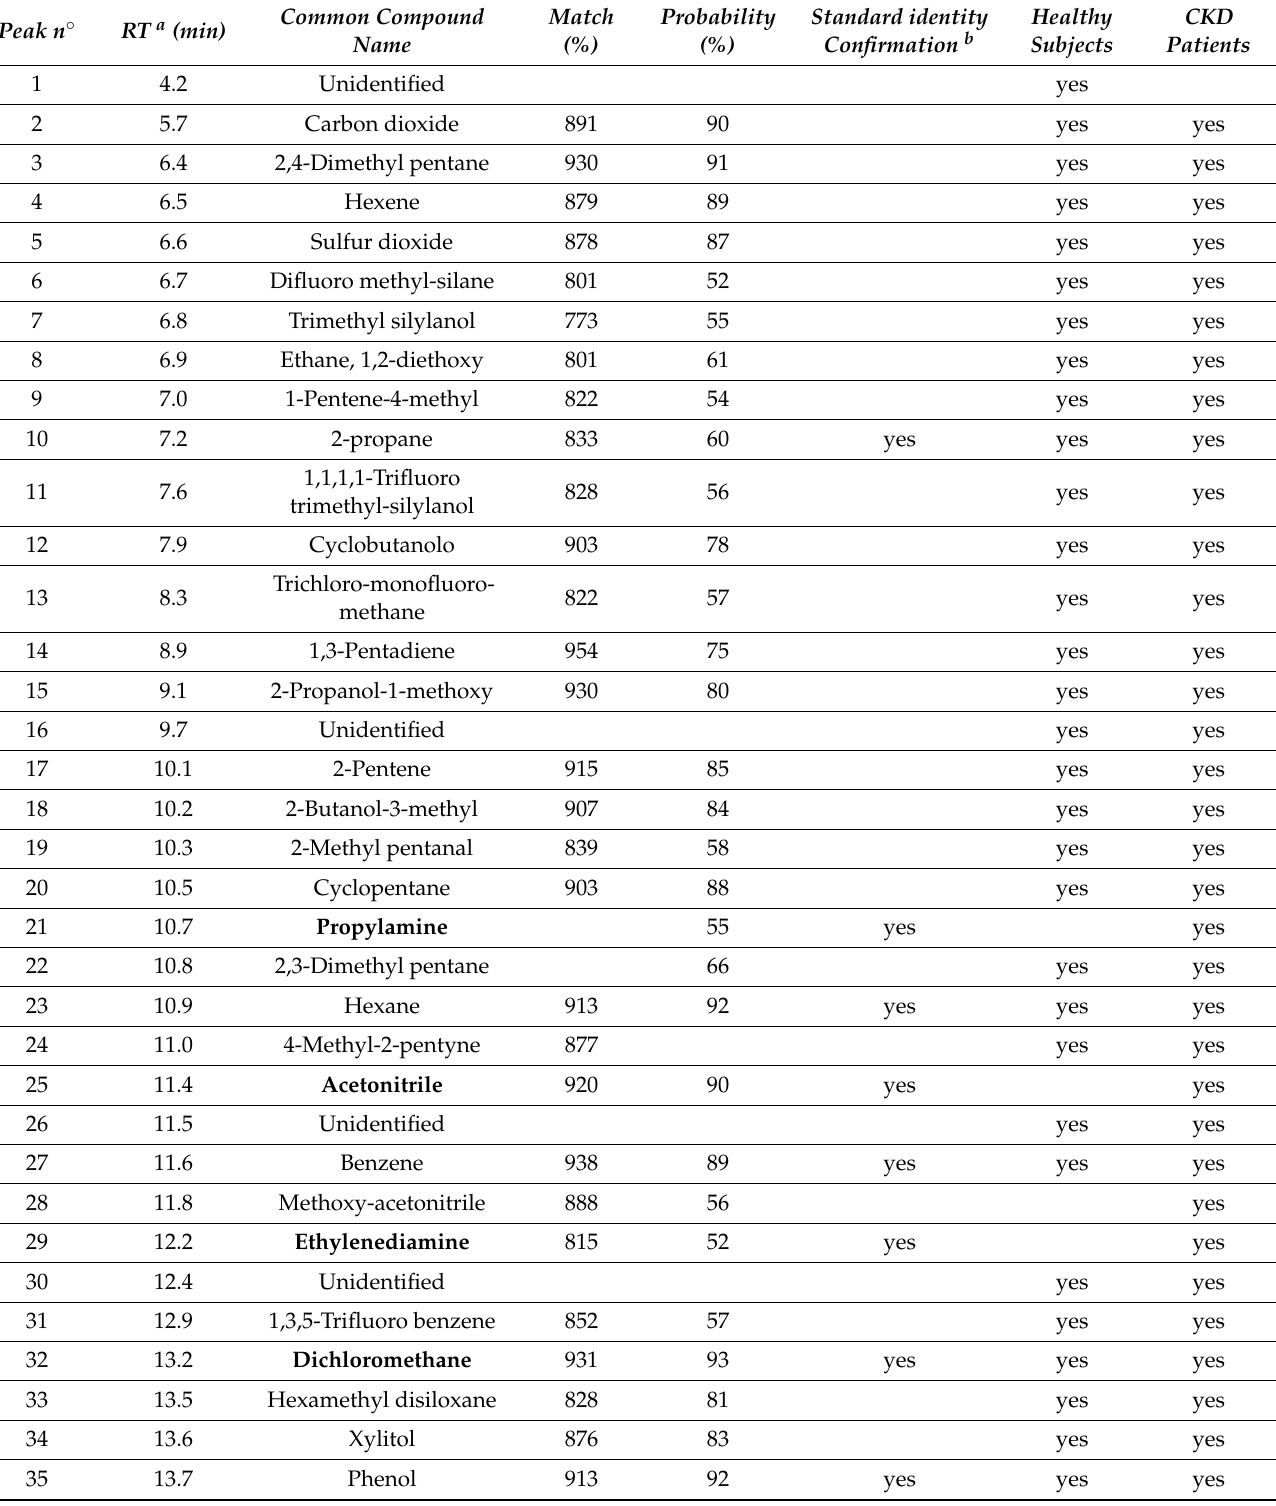
Table 6. List of molecules detected (S/N ≥ 3) in the breath of the twenty healthy subjects and four CKD-affected patients prior to undergoing a kidney